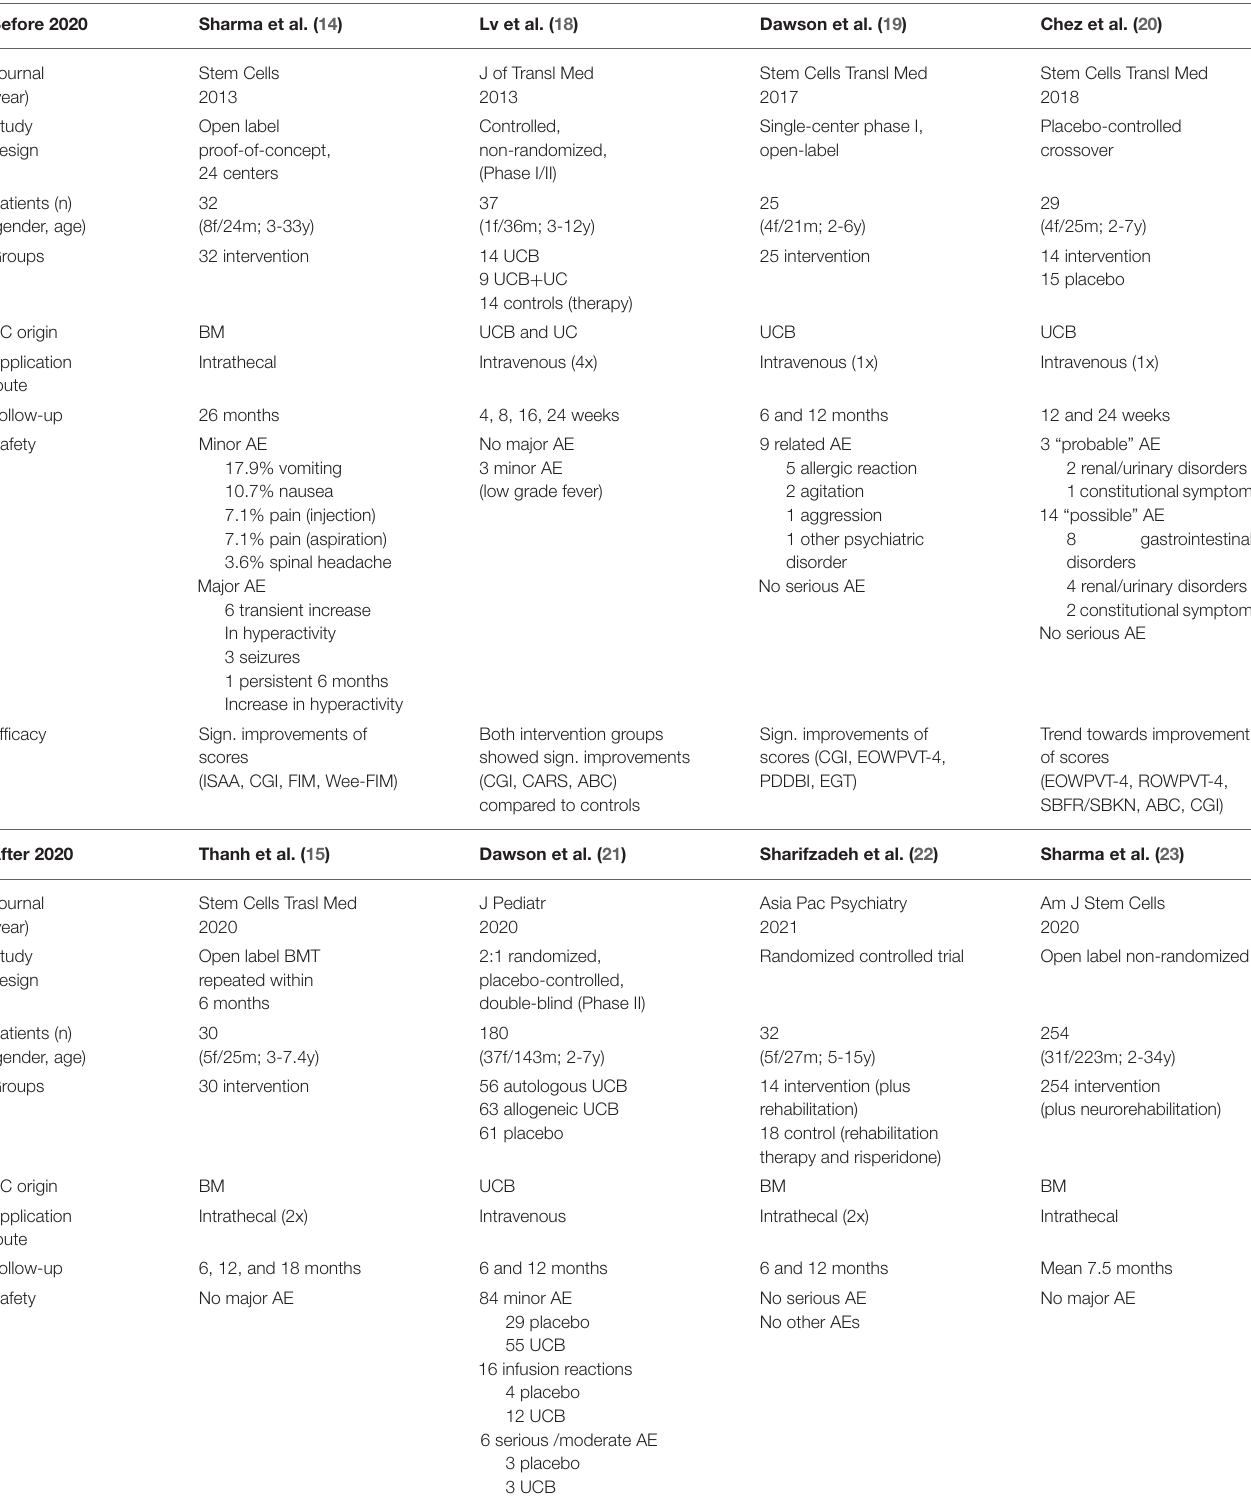
TABLE 2 | Published investigations reporting intrathecal or intravenous application of either autologous or allogenic stem cell transplantation for children with autism spectrum disorder